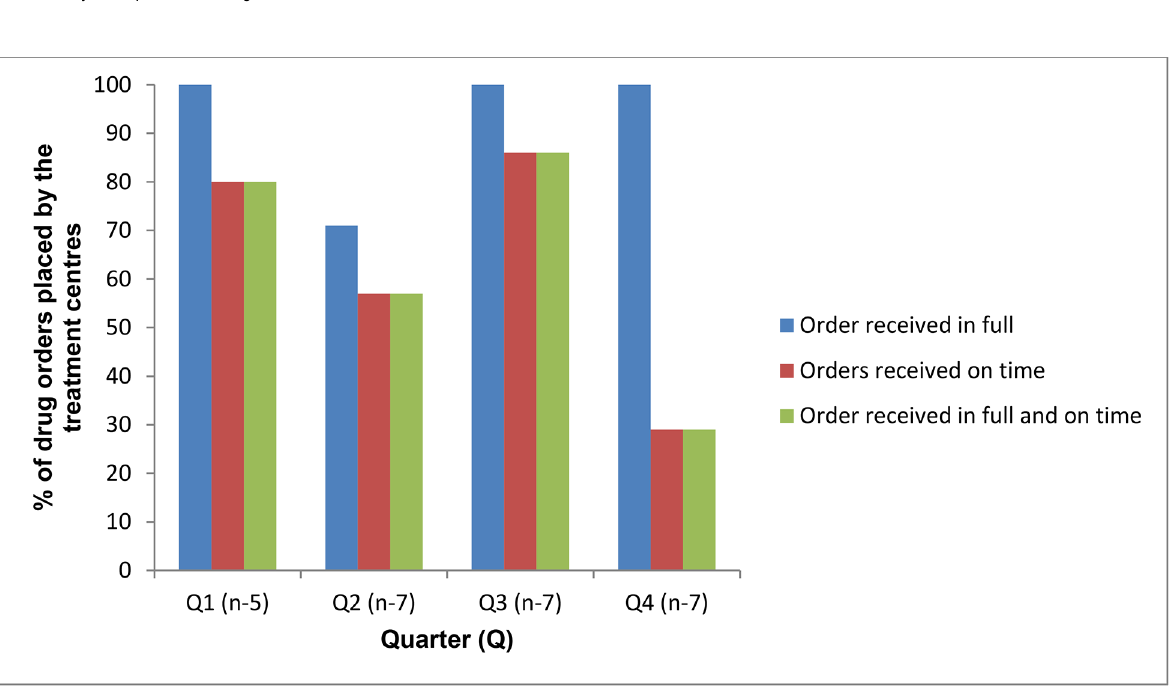
Fig 4. Proportion of multi-drug resistant tuberculosis drug orders placed by the treatment centres (n = 7) that were received in full and on time, Nigeria, 2013 (Target = 100%).